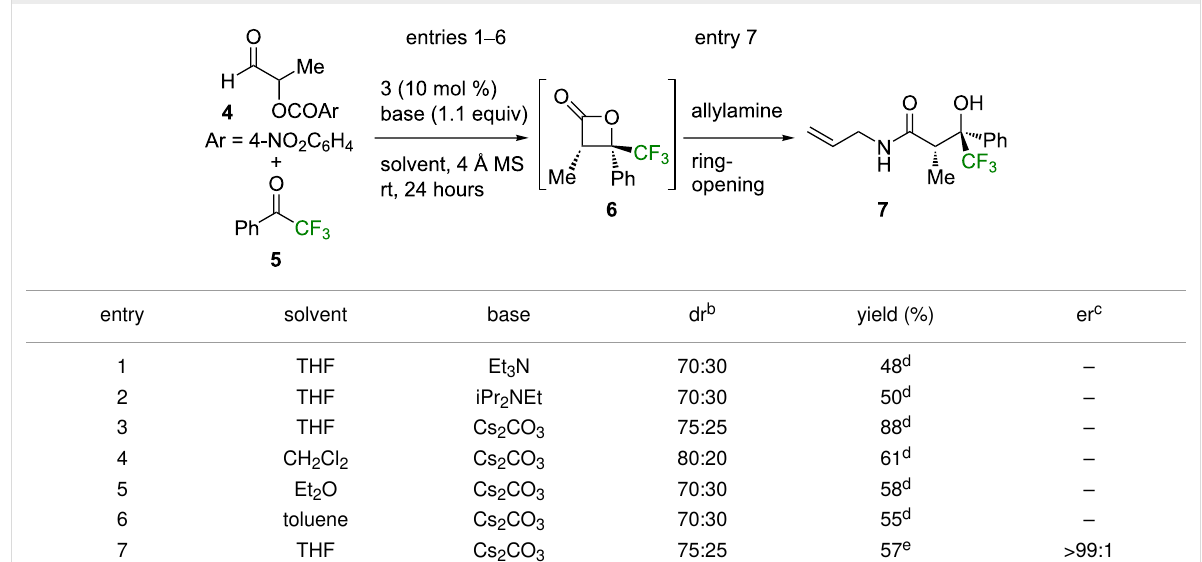
Table 1: Optimization of the NHC-catalyzed formal [2 + 2] cycoaddition.